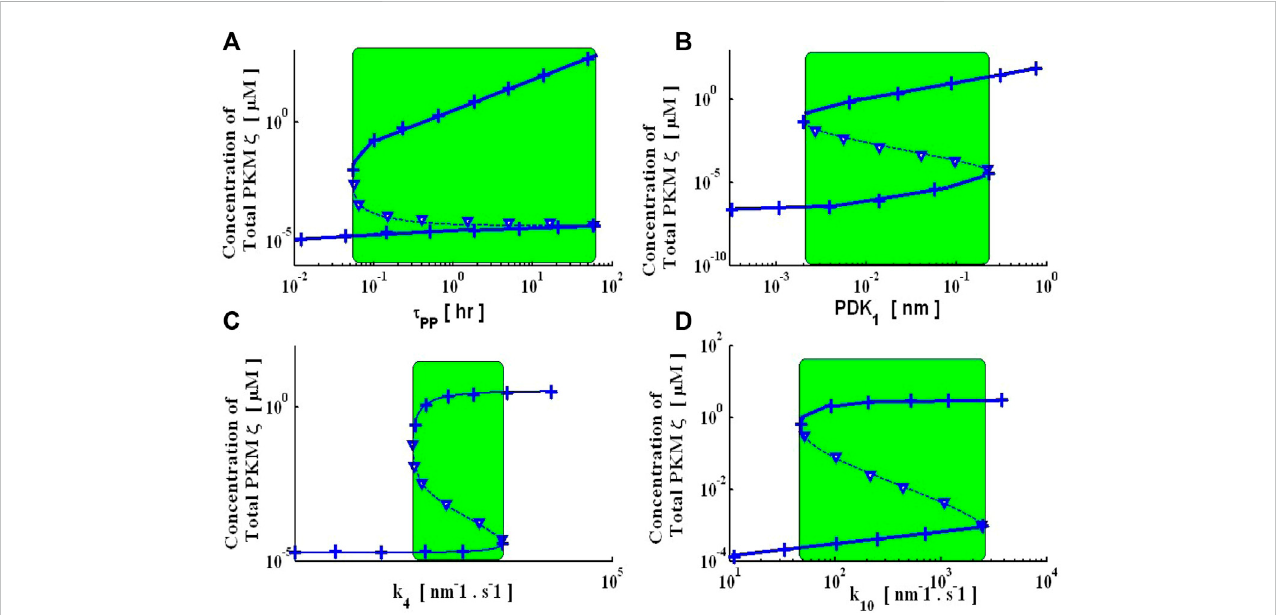
FIGURE 3 Bifurcation diagrams represent the steady-state solutions of this dynamical system with respect to model parameters. These steady-state solutions are generatedwithanon-linearcontinuationbaseglobalsolverandthroughananalyticalexpression.Numeric(solidanddashedlines:solidlinesrepresentstable up- and downstate solutions, whereas dashed lines represent an unstable solution) steady-state solutions are tracked with a non-linear global continuation- based solver. Analytical bifurcation diagrams (cross and downward triangle signs: where the cross represents stable up- and downstate analytical branches, and the downward triangle sign represents the unstable analytical branch) are generated using an analytical expression. Four key parameters are selected for generating bifurcation diagrams. (A) Turnover rate of doubly phosphorylated PKM ζ ( τ PP ), (B) intensity of the PDK1 signal, (C) feedback signal parameter to regulate protein synthesis rate-k 4 , (D) activity regulation parameter k 10 .